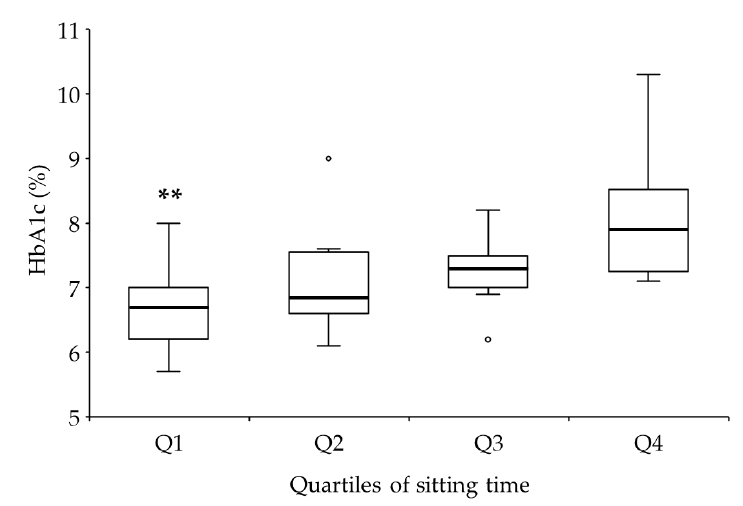
Figure 2. Quartiles of sitting time (ST) with glycated hemoglobin (HbA1c). The cut-off points for quartiles of ST were 4.6, 6.0, and 8.0 h / day. The black solid line indicates the median, the box represents the lower and upper quartiles, the upper and lower adjacent lines indicate the minimum and maximum values, and hollow circles represent outliers. ** p < 0.01 compared to quartile 4.